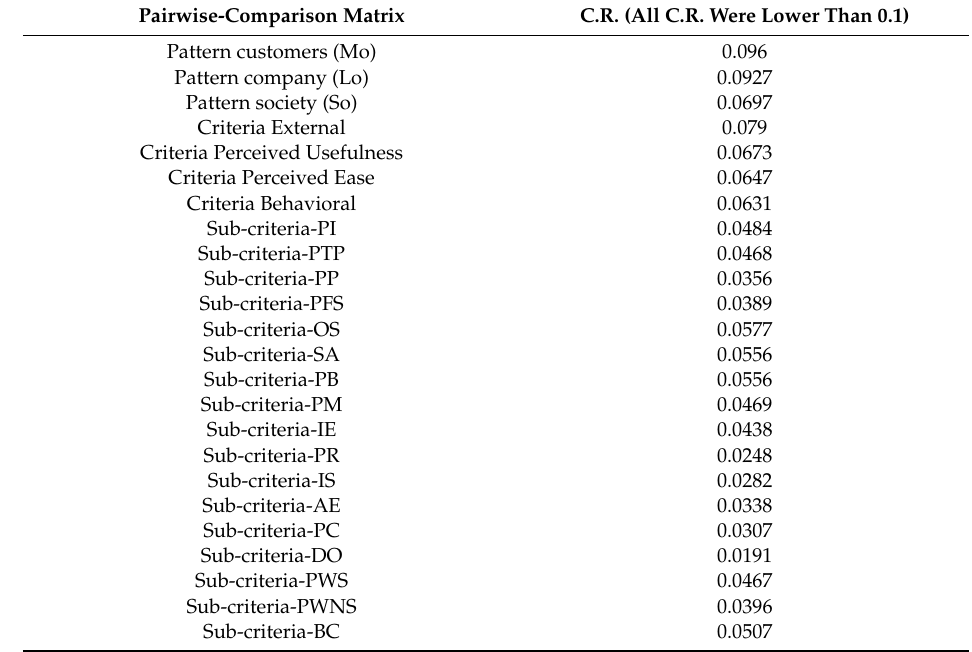
Table 6. C.R. numbers of ANP